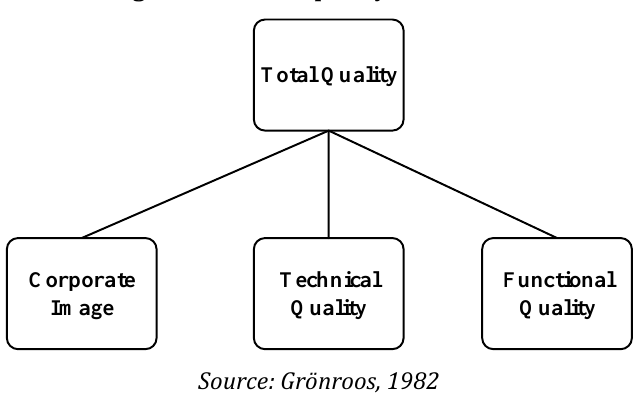
Figure 3: Service quality dimensions